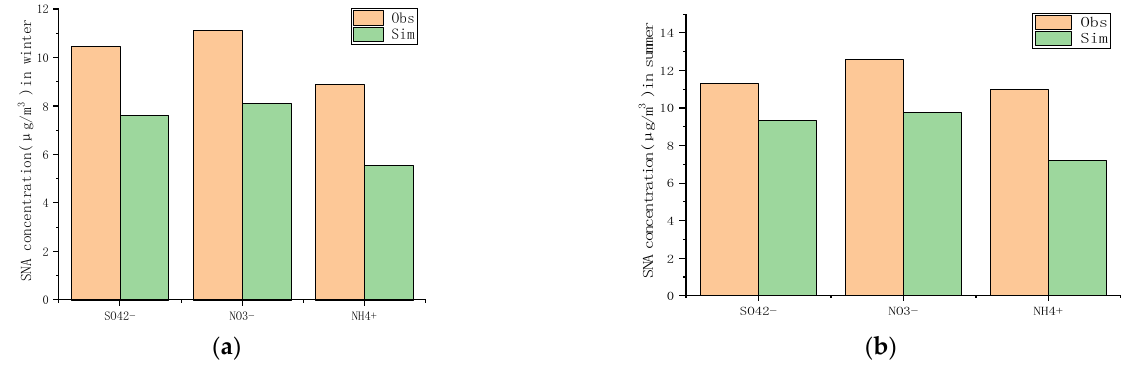
Figure 5. SNA concentrations in Beijing (Obs: observation; Sim: simulation). ( a ) the SNA concentrations in winter, ( b ) the SNA concentrations in summer.